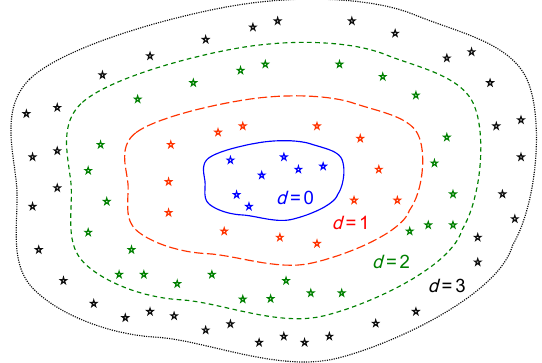
Fig. 5 Multiple layers of a single cloud of a given